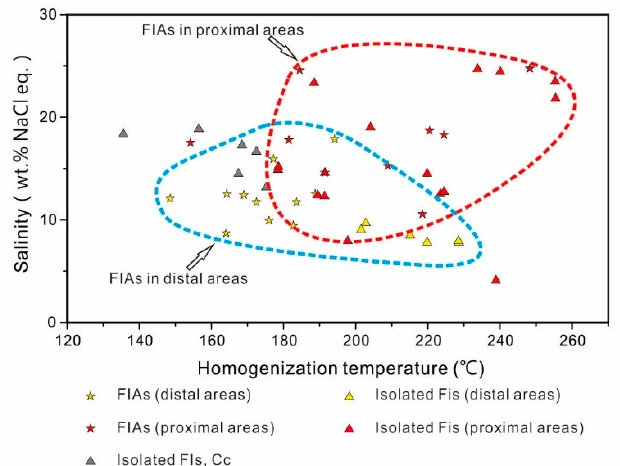
Figure 11. Cross-plot of salinity, calculated from final melting temperatures (T m ) of FIAs and isolated fluid inclusions, versus homogenization temperatures (T h ) from FIAs and isolated fluid inclusions of Rd3 and Cd dolomite.